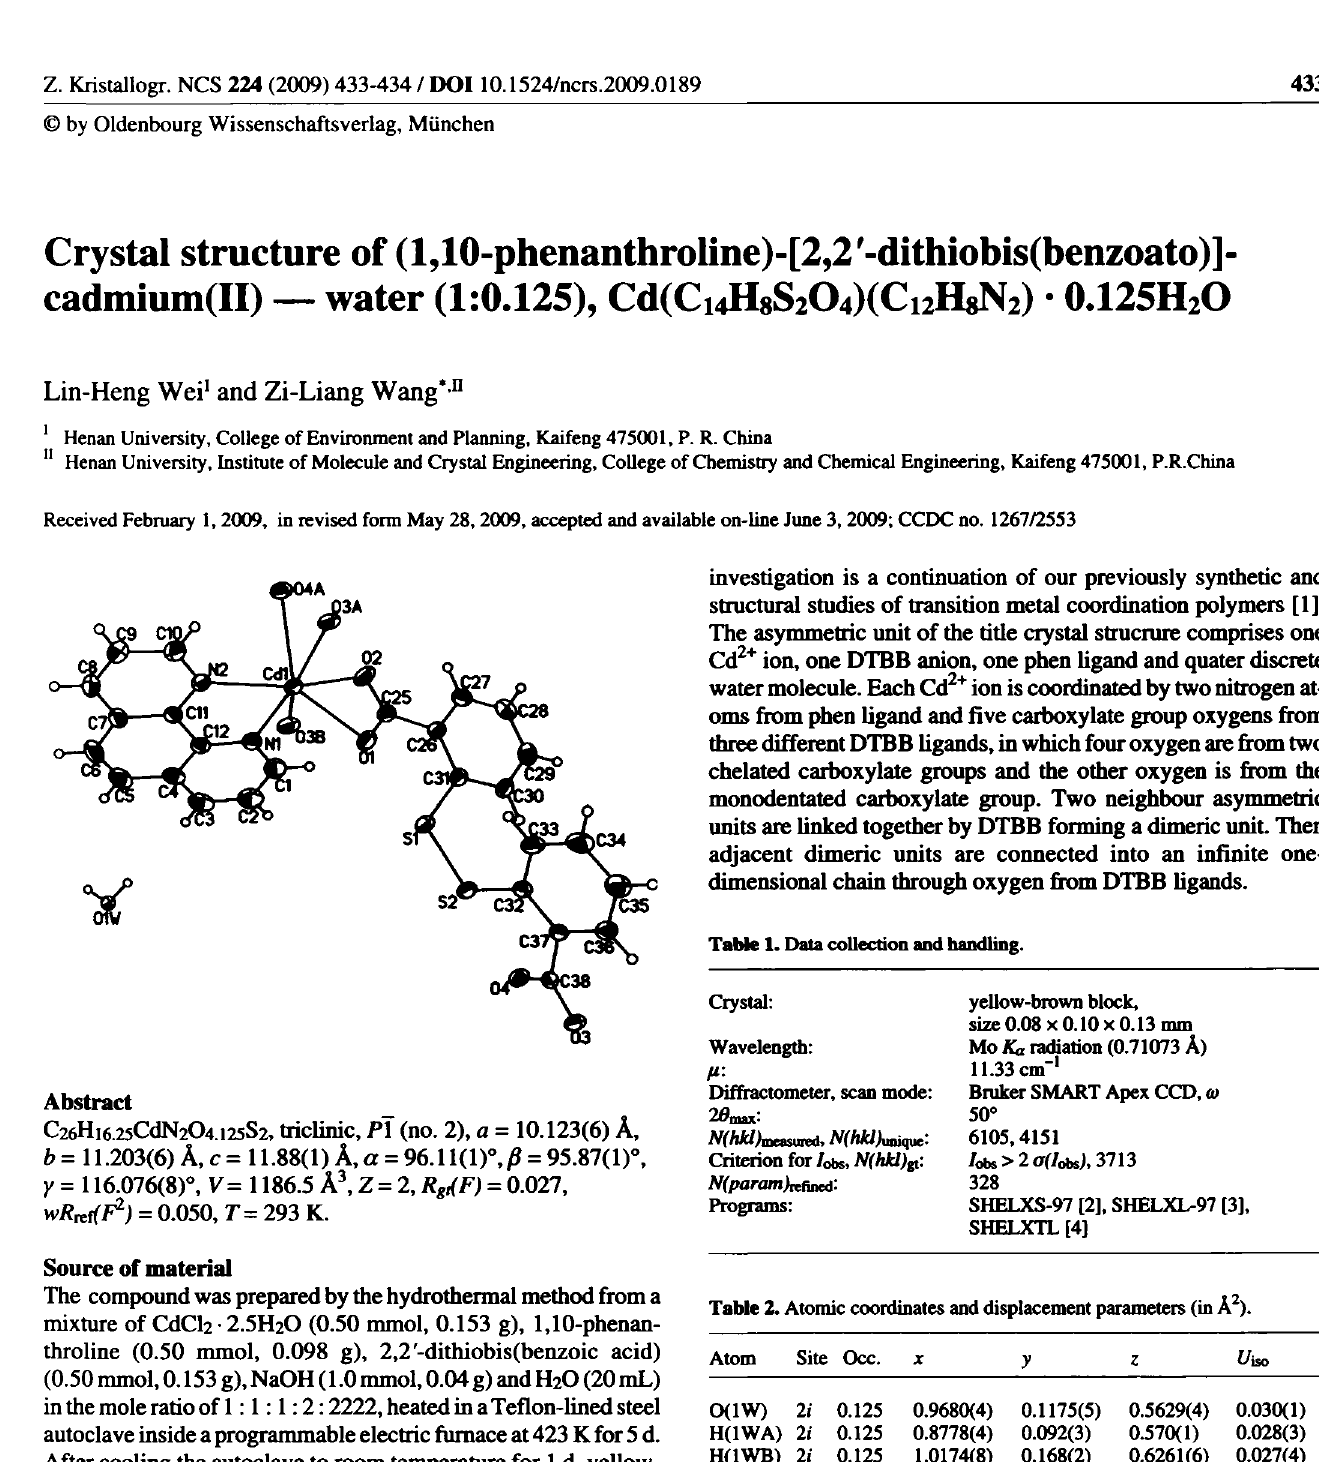
Table 2. Atomic coordinates and displacement parameters (in Â 2